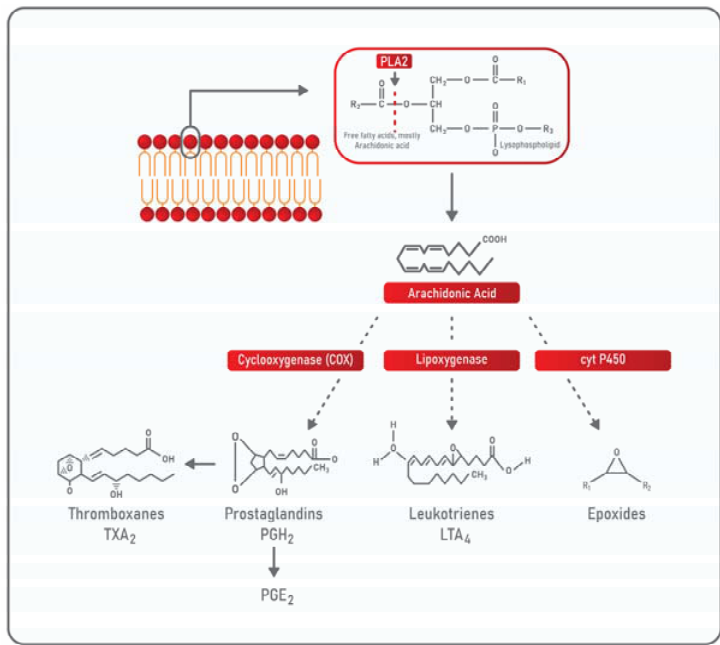
Figure 1. Schematic representation of PLA 2 cascade. PLA 2 acts on membrane phospholipids catalyzing the hydrolysis of acyl-ester bonds at the sn-2 position. Upon this hydrolysis, free fatty acids, mainly arachidonic acid (AA), are released. AA is therefore metabolized by COX enzymes to release PGH2, the precursor of thromboxanes and of the highly inflammatory PGE2. AA is also metabolized by lipoxygenase to produce leukotrienes, another class of inflammatory molecules, or by cytochrome P450 to release epoxides.